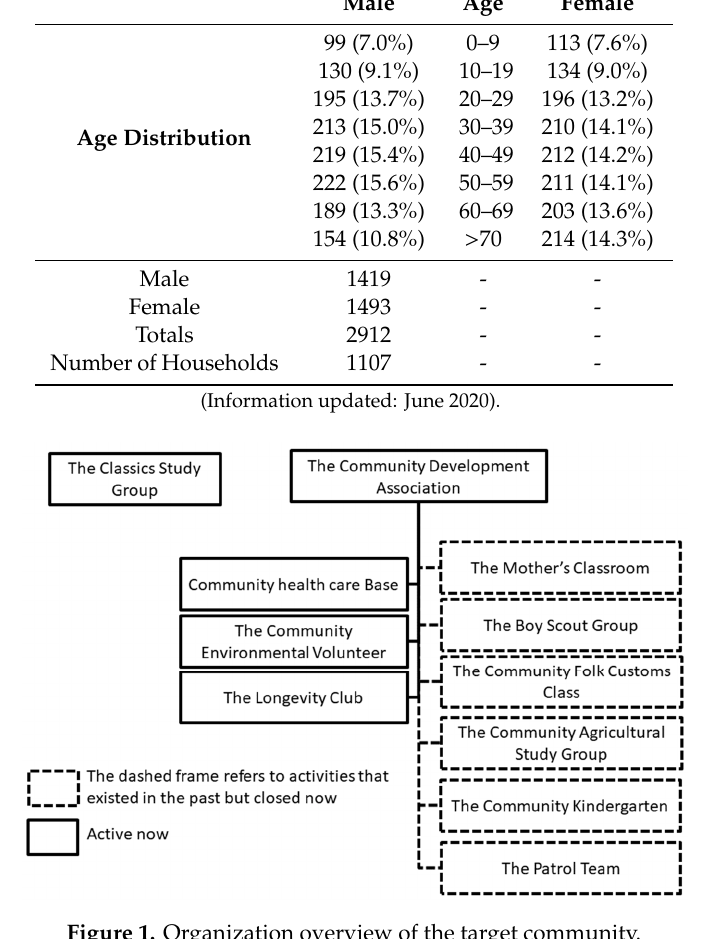
Table 1. Basic information of population in the study area.